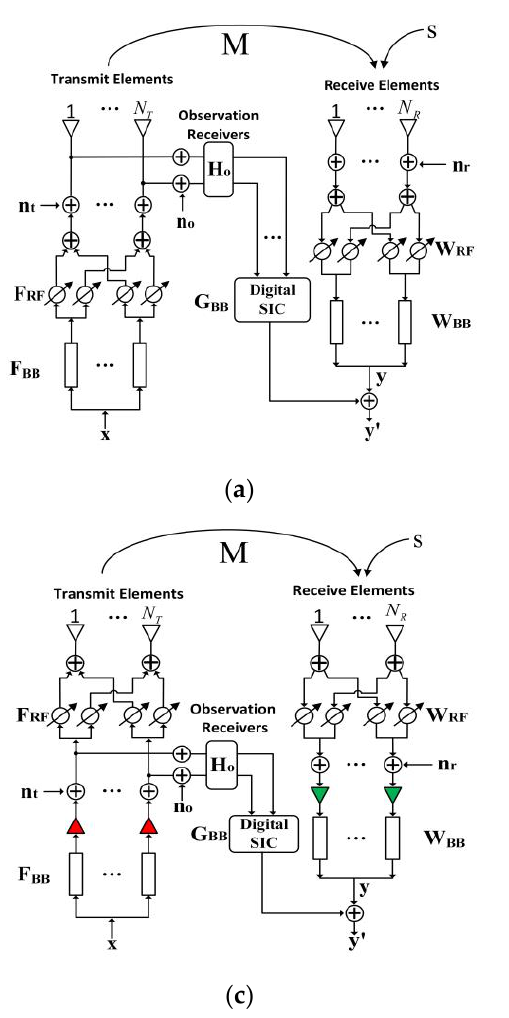
Figure 3. ( a ) HBF-FC-ALSTAR-AO; ( b ) HBF-PC-ALSTAR-AO; ( c ) HBF-FC-ALSTAR-RFO; ( d ) HBF- PC-ALSTAR-RFO. 134